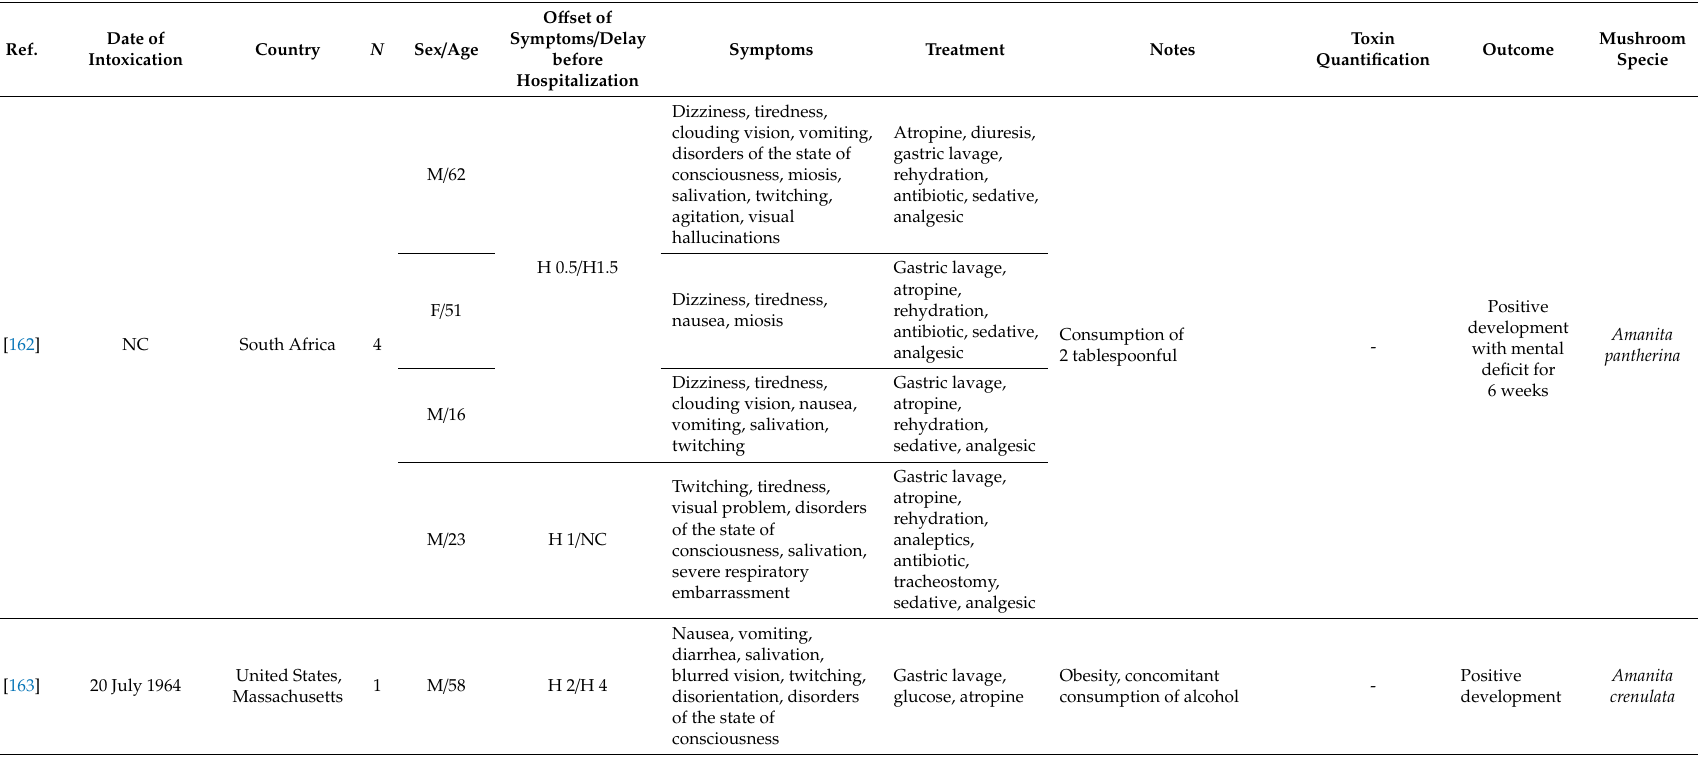
Table 5. Cases of ibotenic acid, muscimol, and muscarine poisoning.